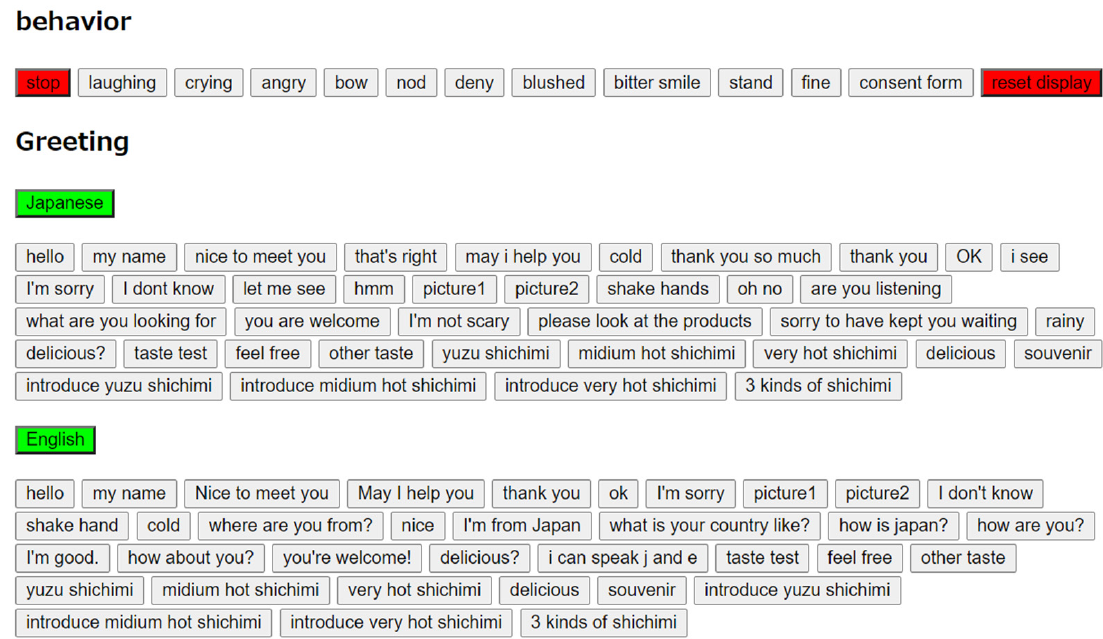
Figure 3. User interface for robot operation.